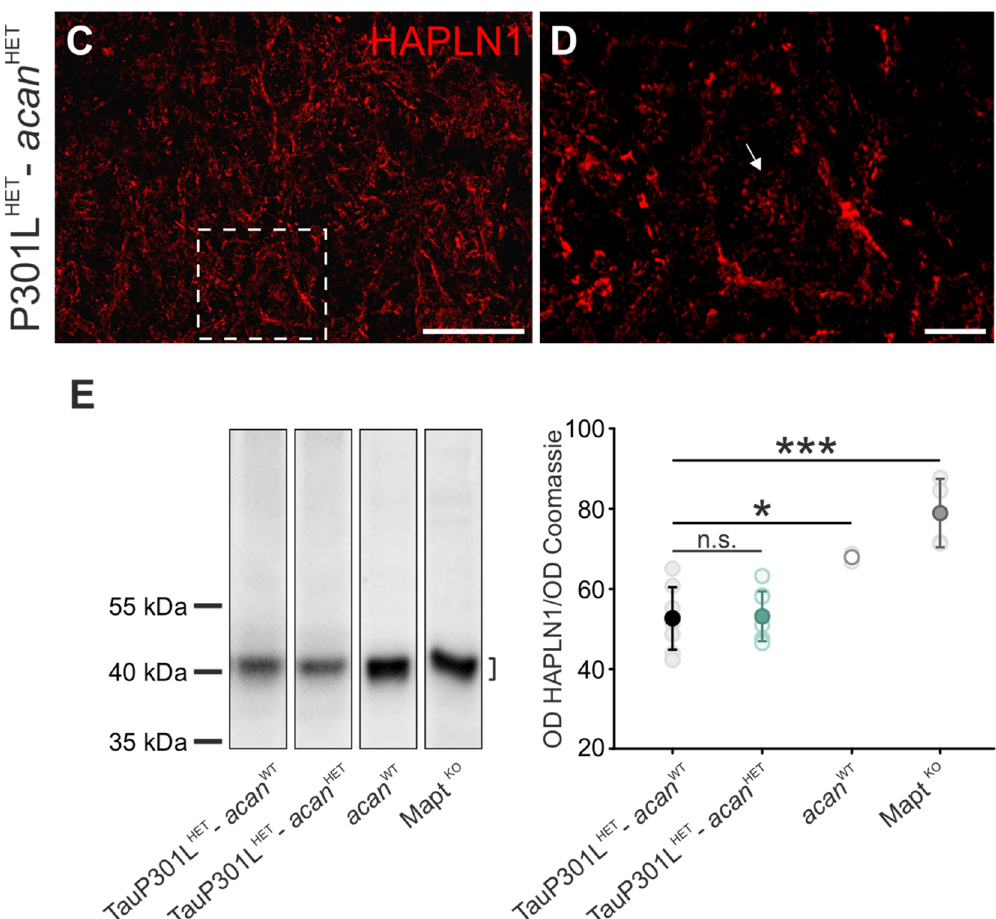
Figure 3. Characterization of HAPLN1 in the Mo5 of TauP301L- acan mice. ( A – D ) Immunohistochemical analysis of HAPLN1 (AF2608 (R&D Systems)) in the motor trigeminal nucleus (Mo5) of 3 TauP301L HET - acan WT ( A , B ) and 3 TauP301L HET - acan HET mice ( C , D ). High magnification confocal images ( B , D ) of HAPLN1 immunoreaction visualize location and structure of immunoreaction. Comparison of the structure of HAPLN1 immunoreaction revealed slight genotype-specific difference ( B , D ). HAPLN1 immunoreaction was mostly detected extracellularly in TauP301L HET - acan HET ( C ) and TauP301L HET - acan WT mice ( A ). Additionally, an intracellularly clustered HAPLN1 immunoreaction was detected in a few cells of both genotypes ( B , D , arrows). ( E ) Western blot analysis of HAPLN1 protein level (AF2608 (R&D Systems), at ~40 kDa) in the brainstem of TauP301L HET - acan HET and TauP301L HET - acan WT mice did not reveal any genotype-specific difference ( p = 0.885, n = 8, t -test). HAPLN1 protein amount was significantly increased in acan WT mice compared to TauP301L HET - acan WT mice ( p = 0.009, acan WT n = 3, TauP301L HET - acan WT n = 8, t -test). Mapt KO mice revealed a significantly increased HAPLN1 protein level compared to TauP301L HET - acan WT mice ( p < 0.001, Mapt KO n = 4, TauP301L HET - acan WT n = 8, t -test). For Western blot analysis, protein extracts from homogenized brainstems of 8 TauP301L HET - acan WT , 8 TauP301L HET - acan HET , 3 acan WT and 4 Mapt KO mice were used. Optical density (OD) of the specific chemoluminescence signal was quantified in relation to Coomassie stained total protein bands. Quantified areas on the Western blot lanes were marked by a bracket. For illustration of exemplary blot lanes, brightness and contrast were adapted. Data are given as mean ± SD, * p < 0.05, *** p < 0.001, n.s. not significant. Scale bar in ( A , C ) 50 µ m, in ( B , D ) 10 µ m. Western blot analysis was performed to investigate HAPLN1 protein level (Figure 3E). The protein amount of HAPLN1 did not yield any genotype-specific difference in TauP301L HET - acan HET and TauP301L HET - acan WT mice (Figure 3E). Western blot analysis